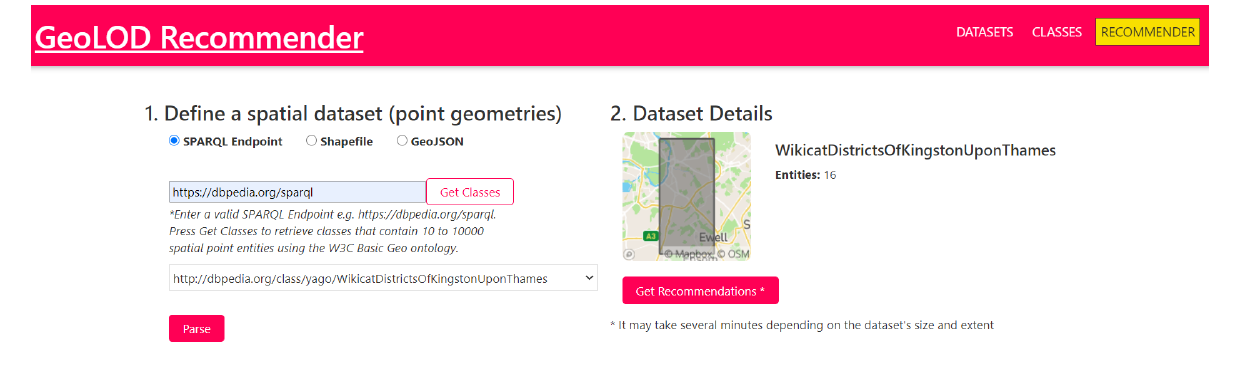
Figure 6. The on-the-fly recommender interface.